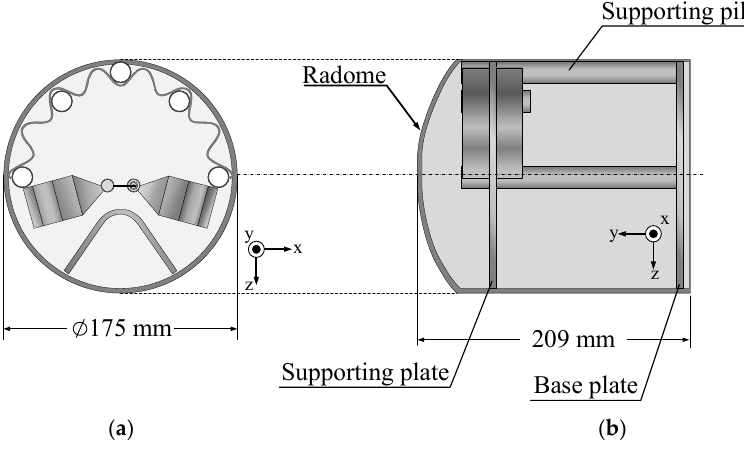
Figure 2. Geometry of the portable wideband directional antenna with radome: ( a ) top view, ( b ) side view.